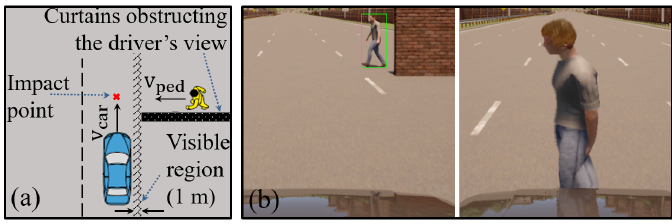
Figure 15. Evaluation scenario from [38]: ( a ) bird’s-eye view ( b ) Screenshots from the